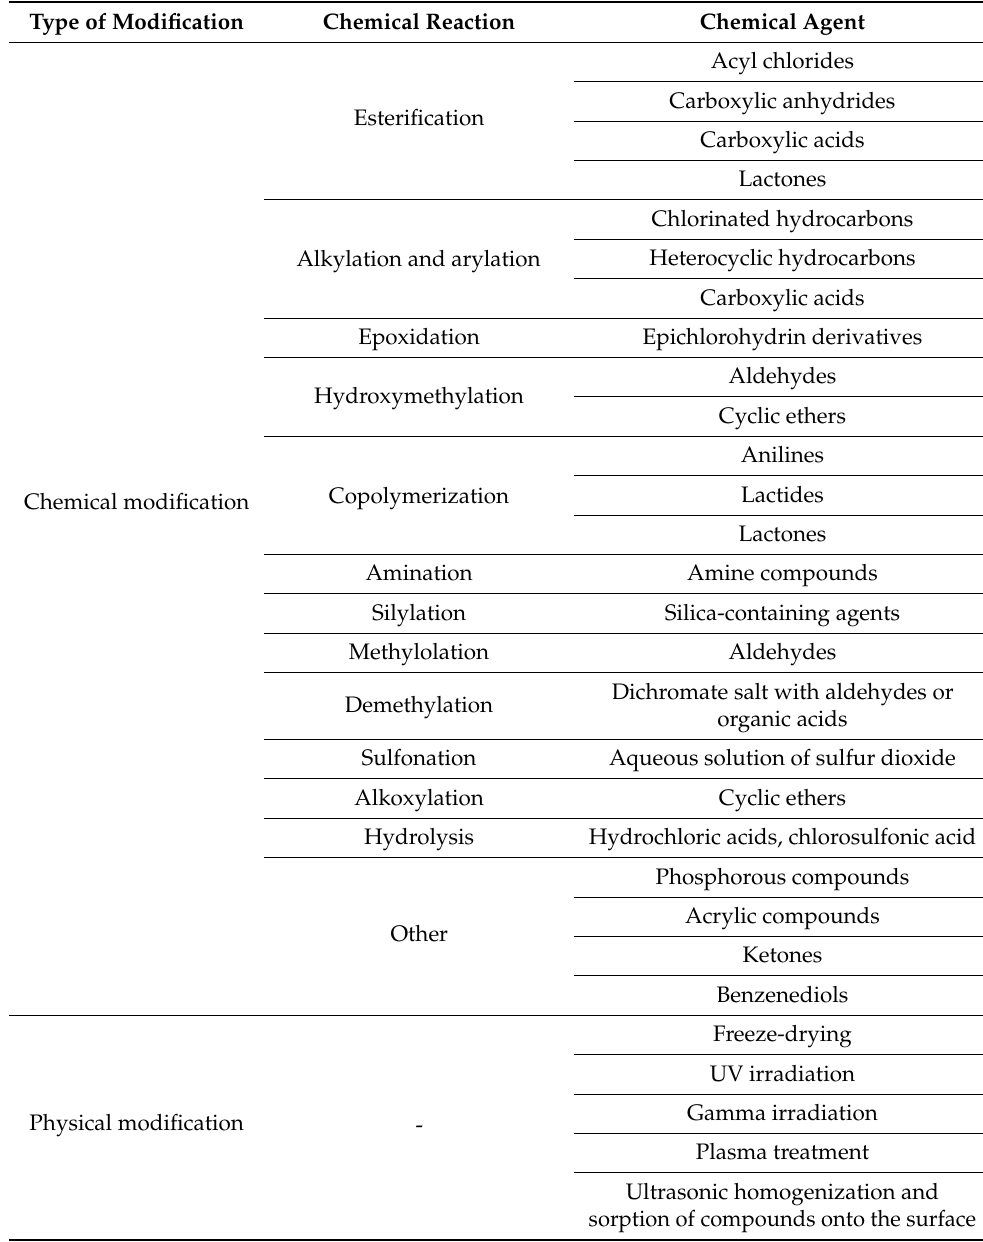
Table 4. Modification methods of lignin and chemical